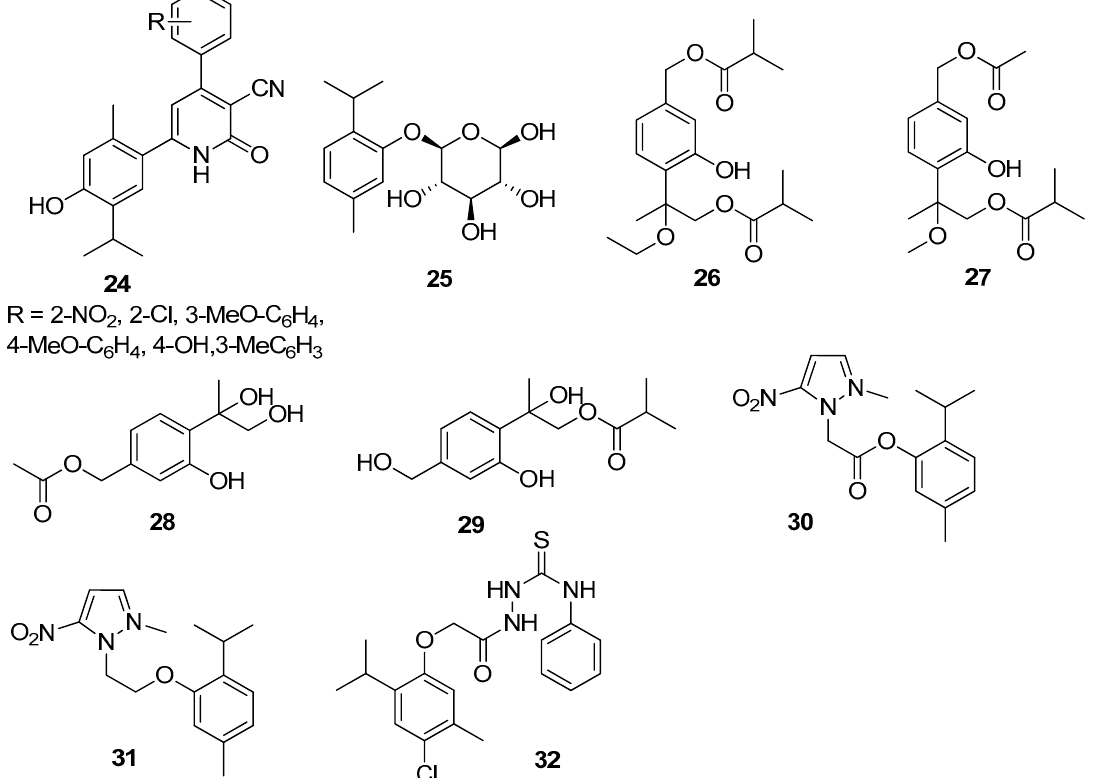
Figure 8. Representative thymol derivatives with antibacterial activity.